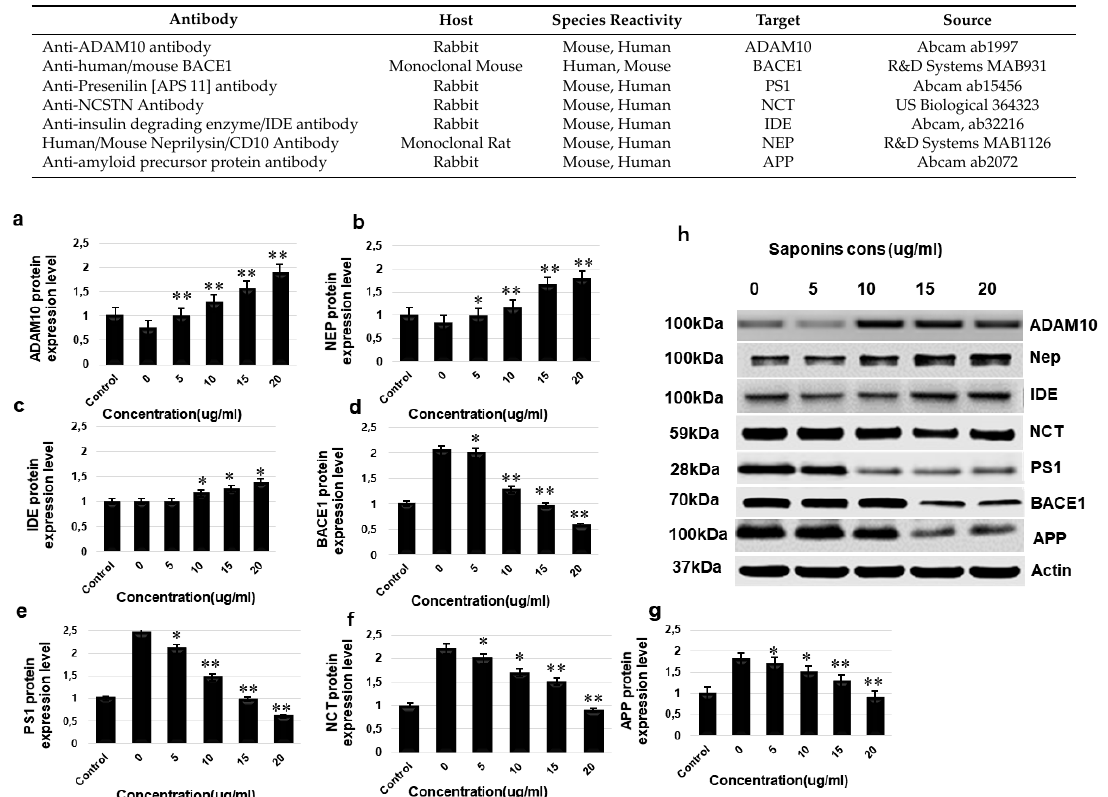
Table 2. List of antibodies used for Western blotting.